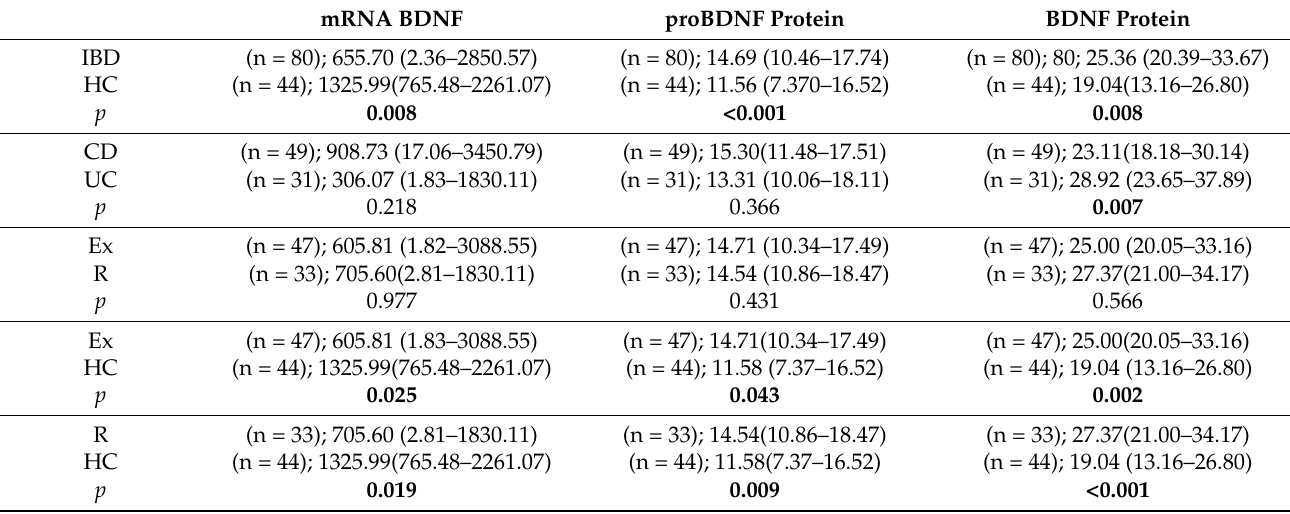
Table 2. Expression of neurotrophins in study’s